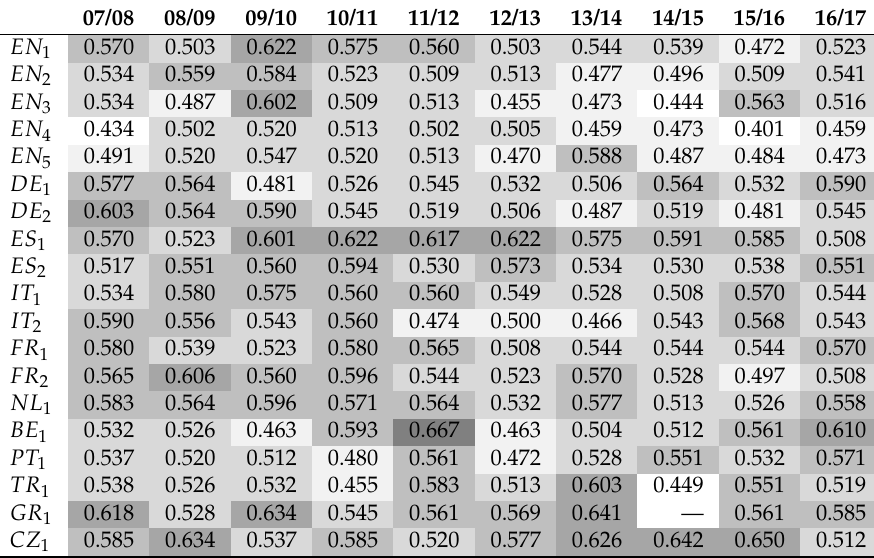
Table 8. Results of ˆ p 1 for leagues in single